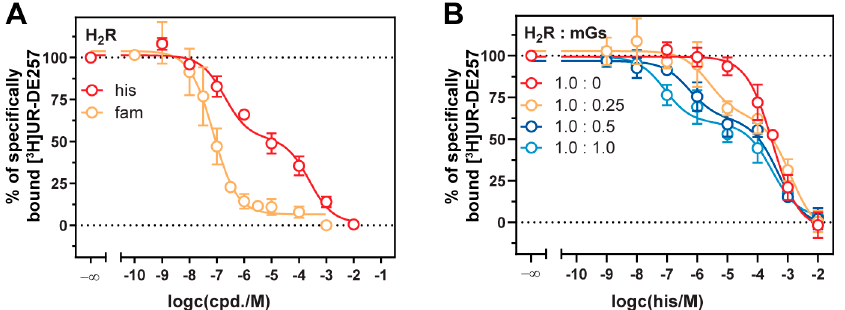
Figure 4. Comparison of radioligand displacement curves at cells co-expressing the H 2 R and mGs. ( A ) [ 3 H]UR-DE257 (50 nM) was displaced by either histamine or famotidine. Presented data are means ± SEM of three independent experiments ( n = 3), each performed in triplicate using HEK293T cells stably co-expressing the H 2 R-NlucC and NlucN-mGs constructs. ( B ) Displacement of [ 3 H]UR-DE257 (50 nM) by histamine using HEK293T cells transiently transfected with indicated DNA amounts (in µg) of the H 2 R-NlucC and NlucN-mGs constructs 72 h prior to the experiments. Presented data are means ± SEM of three independent experiments ( n = 3), each performed in duplicate.